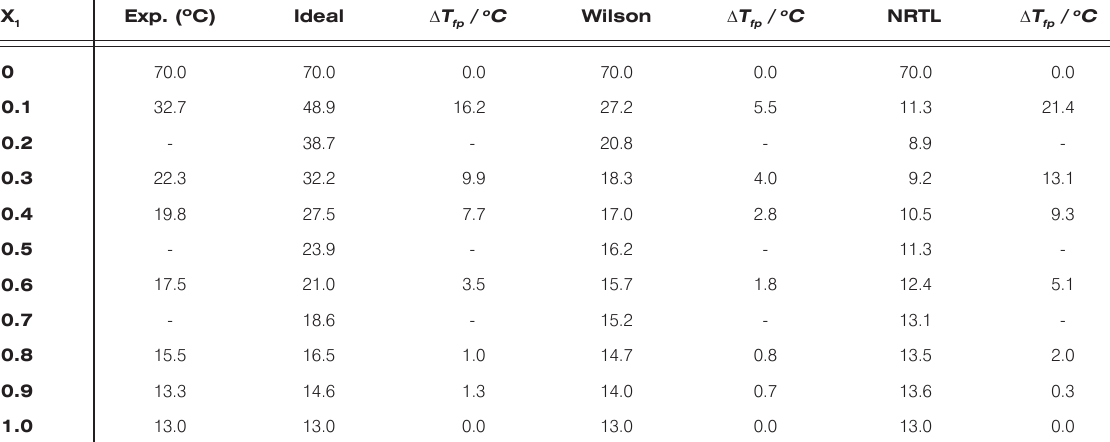
Table 4. Experimental flash points and predictions for Ethanol (1) – Aniline (2).